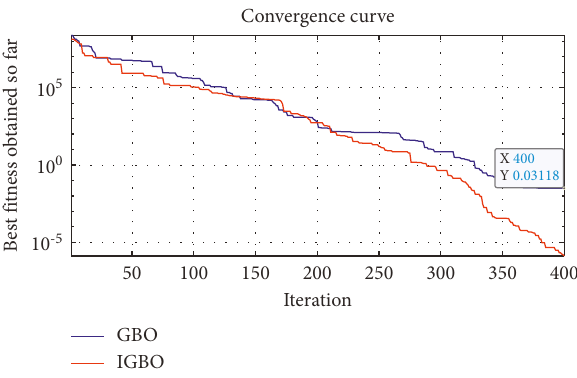
Figure 11: SAE convergence for model